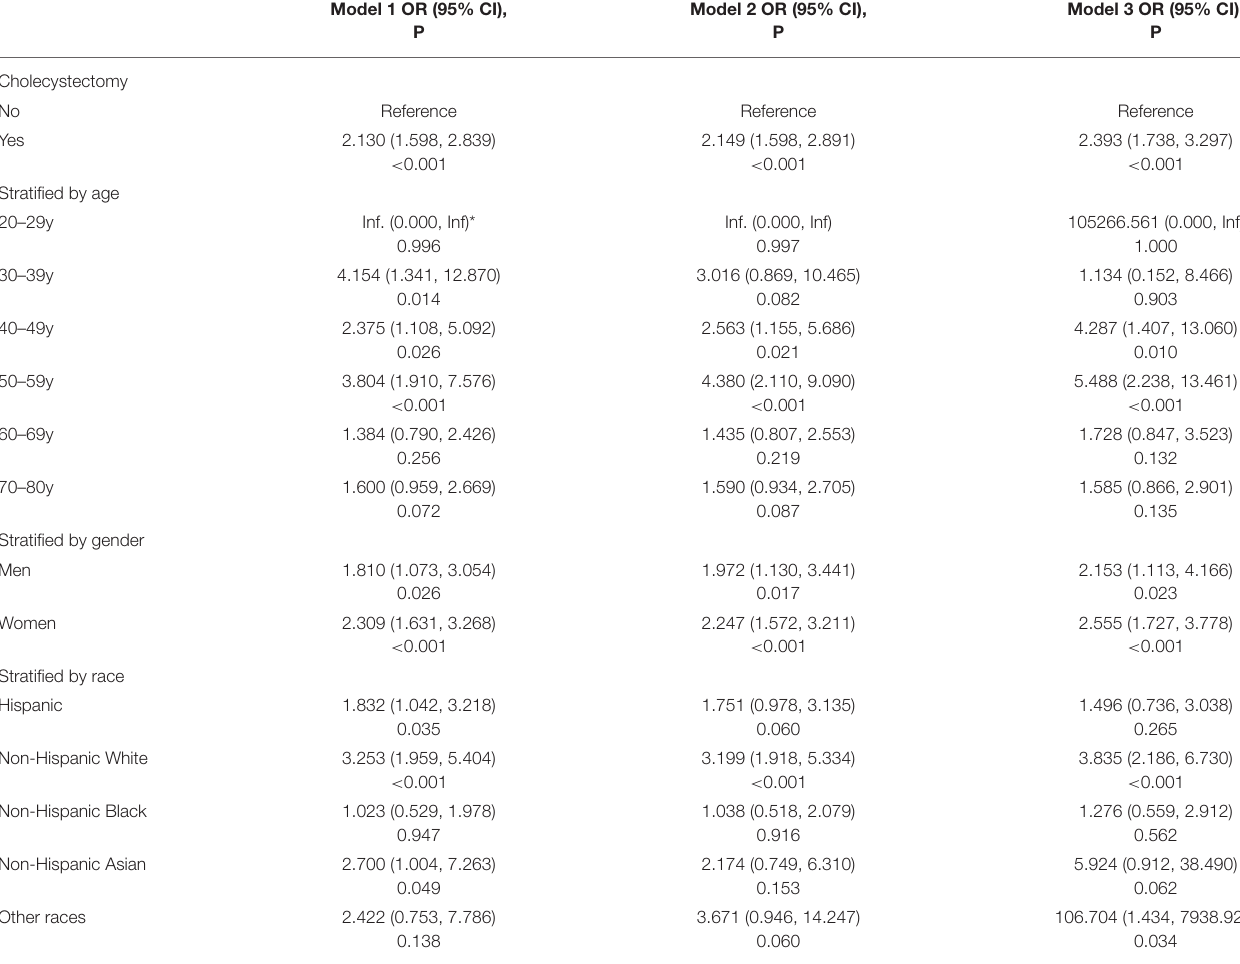
TABLE 3 | Associations between cholecystectomy and liver fibrosis after propensity score matching ( n = 978), NHANES 2017–2018.